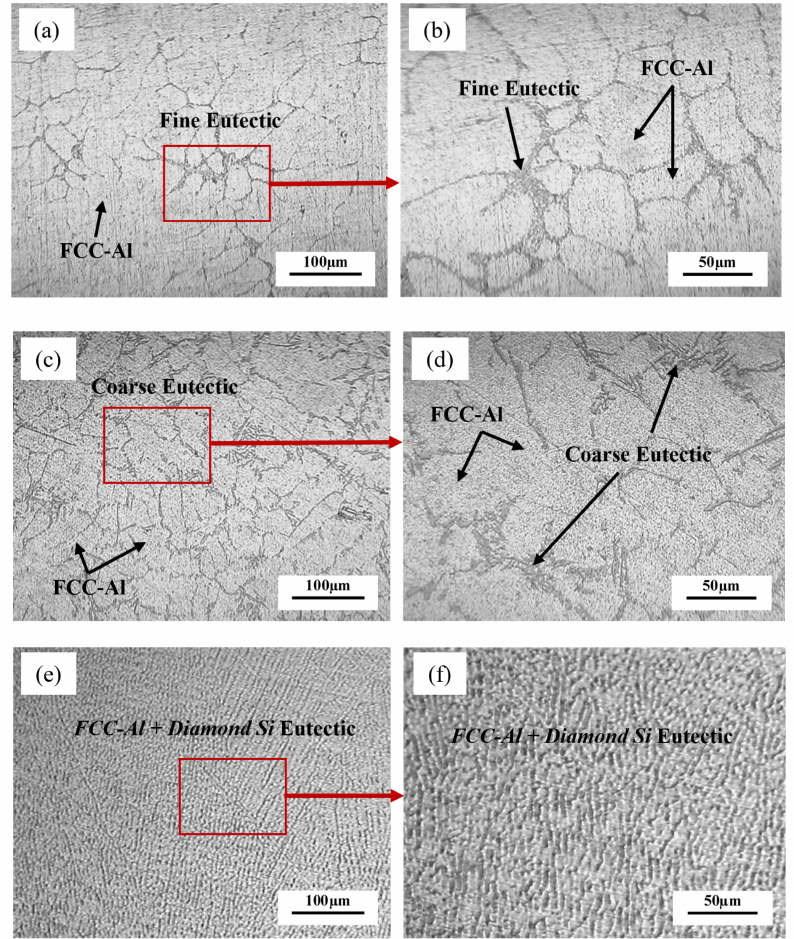
Figure 3. Optical micrographs of ( a , b ) Al–1.3%Si alloy, ( c , d ) Al–1.5%Si alloy, and ( e , f ) Al–13.5%Si alloy at different magnifications to highlight the microstructural